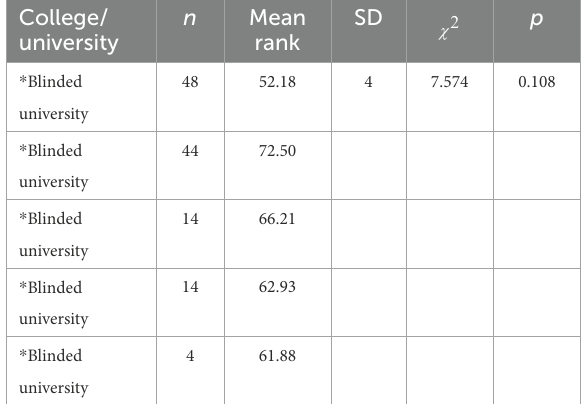
TABLE 8 H-Test results of similarity indexes of postgraduate theses in Austria grouped by institution.